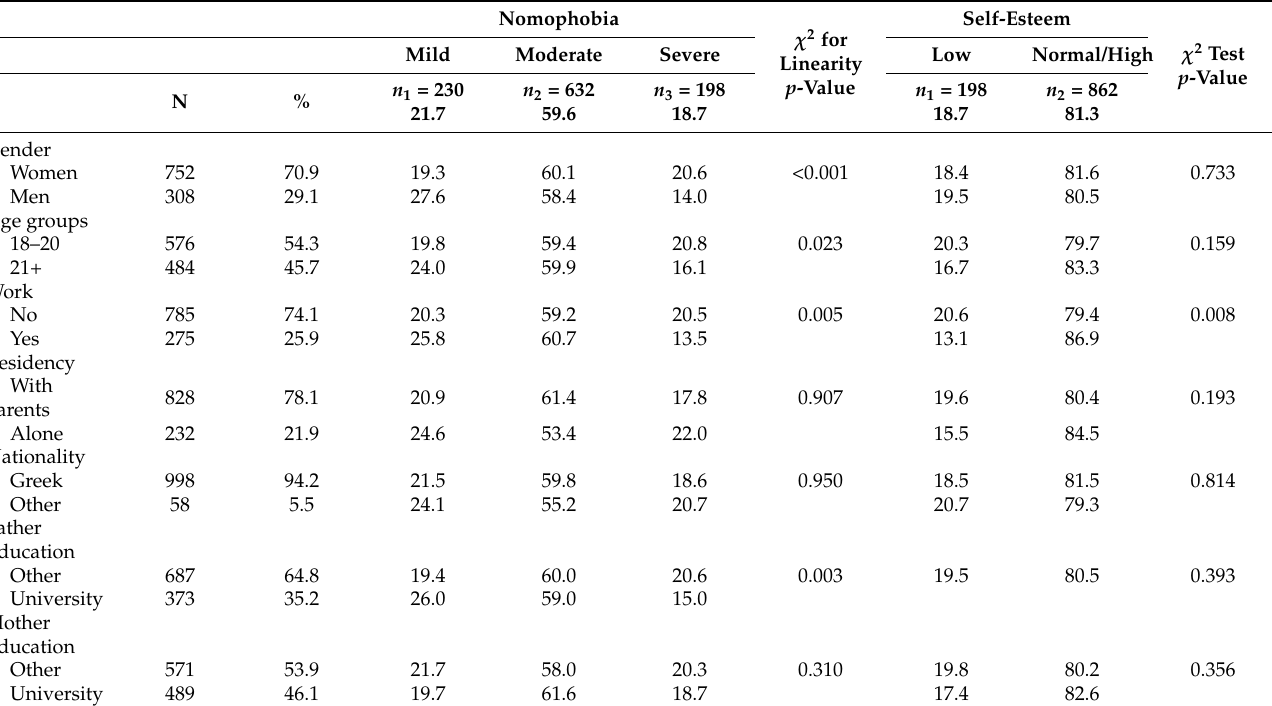
Table 1. Sociodemographic characteristics of study subjects by NMP and self-esteem categories. Nomophobia